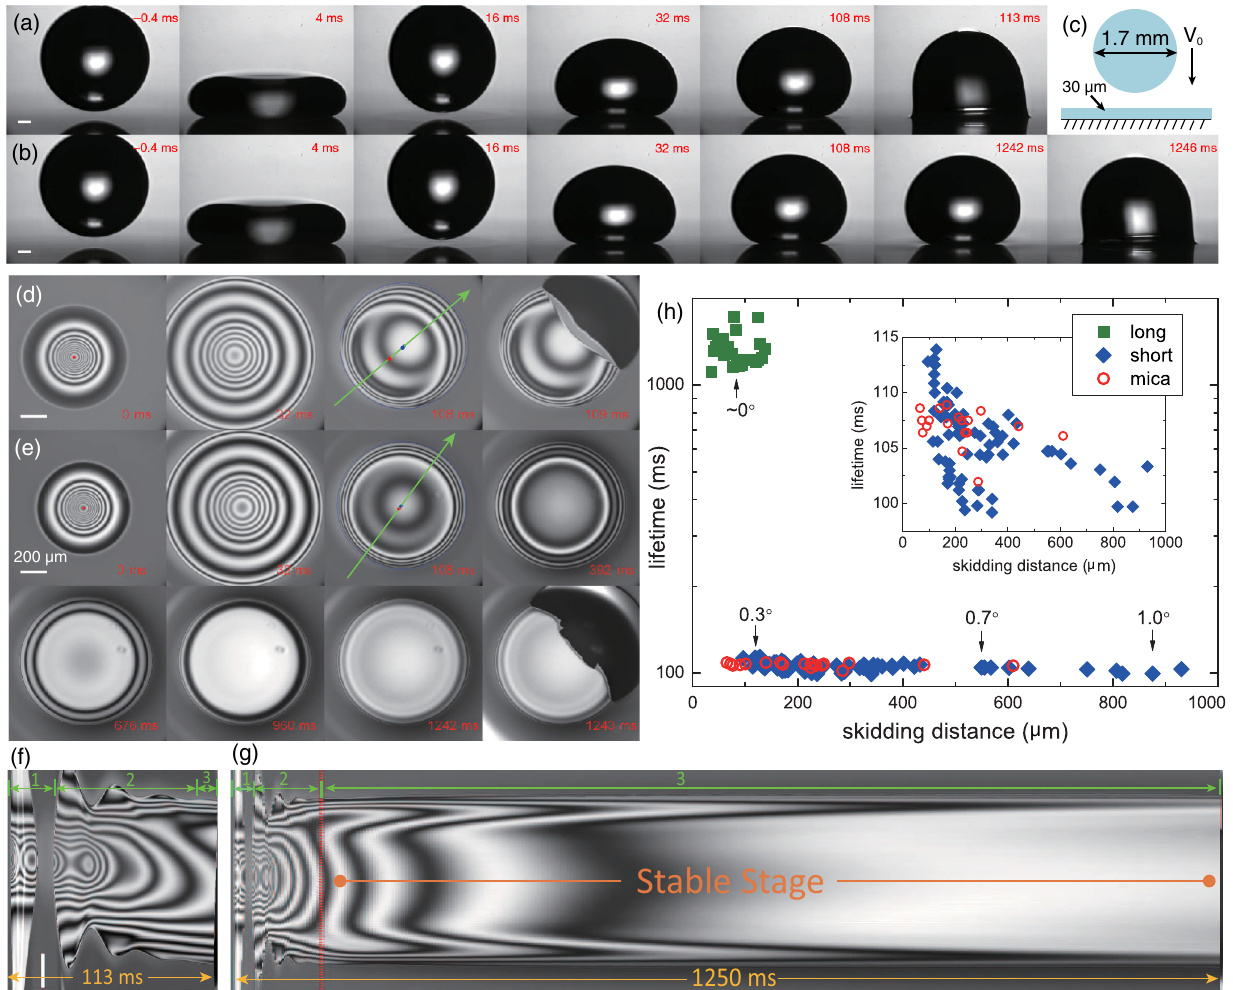
FIG. 1. Short and long lifetimes on inclined and leveled oil-film-coated substrates. All scale bars are 200 μ m. (a),(b) Side view images of a droplet landing on inclined and leveled substrates, respectively, with velocity V 0 ¼ 0 . 32 m = s, droplet diameter d ¼ 1 . 7 mm, drop viscosity 50 cSt, and liquid film thickness 30 (cid:1) 5 μ m. The lifetime is 10 times longer on the leveled substrate. (c) Schematic illustration of the impact. (d),(e) Bottom view of the impact shown in (a) and (b). The green arrow line indicates the direction of skidding, with droplet center moving from the red to the blue spot. Apparently (d) skids much longer and (e) has a more symmetric pattern. (f),(g) Summarizing the entire process of (d) and (e) by plotting the gray value along the green line versus time. We divide it into three stages: (1) rebounding, (2) oscillatory, and (3) stable stages. Panel (g) shows a remarkably long stable stage. (h) Droplet lifetime versus skidding distance at different tilt angles. There exist two distinct states on a liquid surface (solid symbols), while only the short-lifetime state appears on a solid mica surface (open symbols). Inset: Short-lifetime data on a zoomed-in